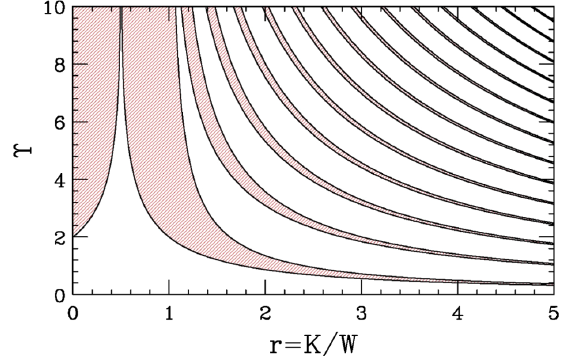
FIG. 1. Beam stability obtained with the 2PA as a function of the wakefield strength represented by ϒ and W , and the space charge strength represented by K . The red areas mark configurations featuring unstable eigenvalues. This plot was taken from [7].